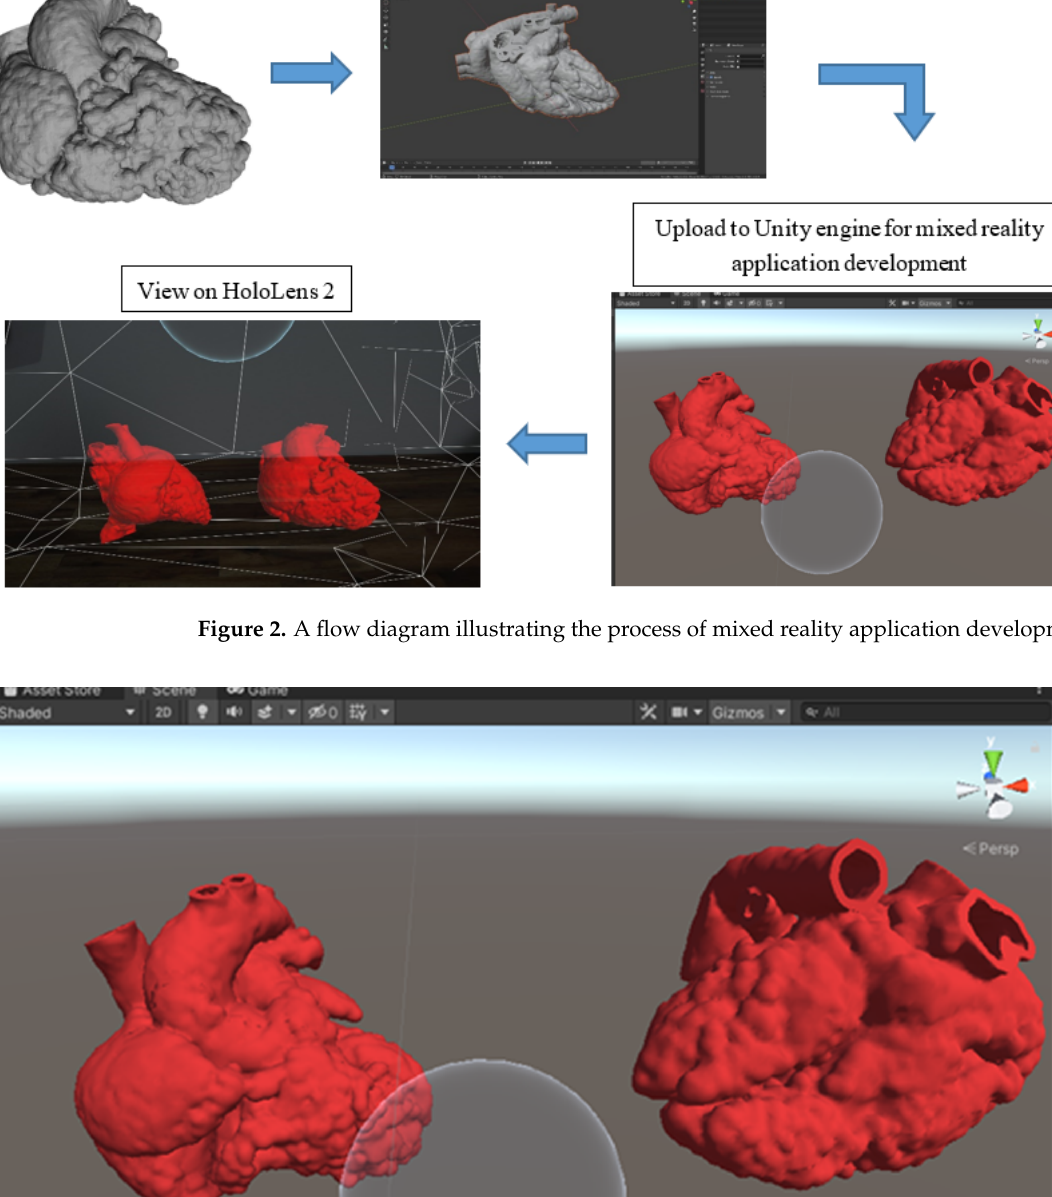
Figure 2. A flow diagram illustrating the process of mixed reality application development.